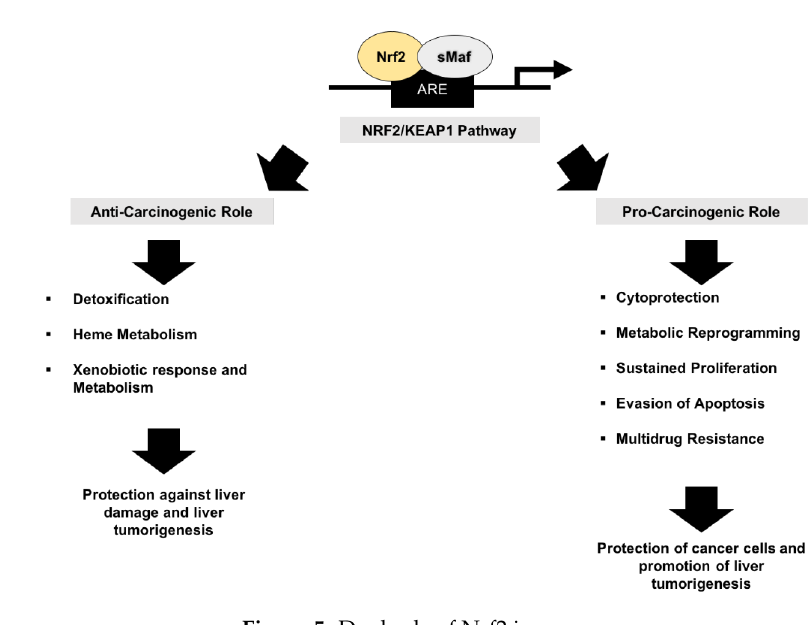
Figure 5. Dual role of Nrf2 in cancer.